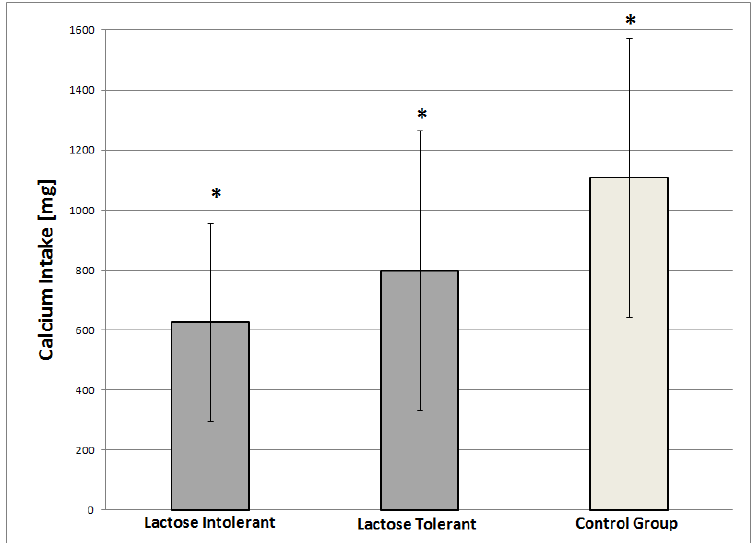
Figure 1. Amount of Ca intake (mg/die) in lactose intolerant ( n = 41), lactose tolerant ( n = 61), and control subjects ( n = 102); *: statistically significant difference between the three groups. There was no difference between the two subgroups in terms of Vitamin D intake ( p = 0.62). About 75% of cases drank milk (98% of whom drank lactose-free cow’s milk and about 2% soy